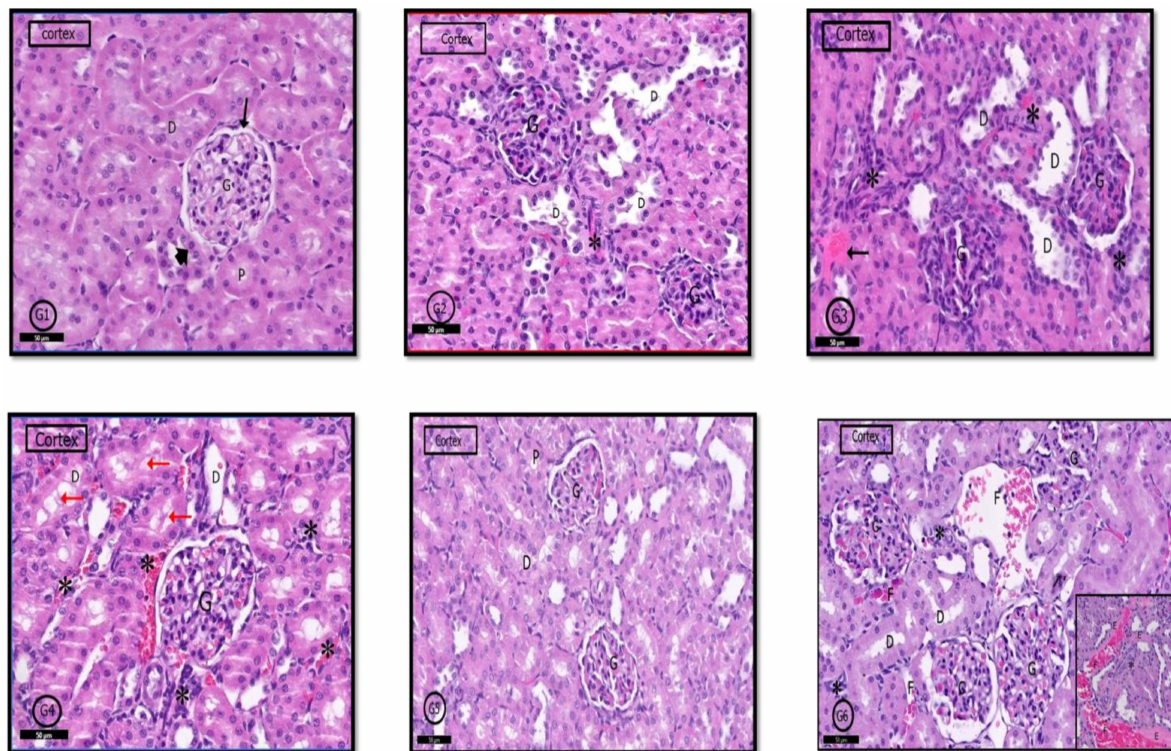
Figure 9. Photomicrographs of the rat renal cortex of different groups: In control rats ( G1 ), normal renal cortical parts like glomerulus (G) in Bowman’s capsule ( ↑ ). (PCT) proximal convoluted tubules (D,P) and (DCT) distal convoluted tubules (head arrow) were seen. ( G2 ) (PILO rats) showed localized areas of degeneration in the form of hypertrophied glomerular capillary loops (G) with dark nuclei. DCT had wide lumen (D); in addition to infiltrated inflammatory cells (*). In ( G3 ) (PILO+LPS rats) and ( G4 ) (PILO+LPS+VPA rats), signs of cortical degeneration were evident in the form of sclerotic glomeruli (G), wide DCT (D), infiltrated inflammatory cells with hemorrhage (*) and areas of exudate ( ↑ ). ( G5 ) (PILO+LPS+Celecoxib rats) showed nearly normal renal cortical architecture of renal corpuscle (G), PCTs (P), and DCTs (D). In general, ( G6 ) (PILO+LPS+VPA+Celecoxib rats) showed similar architecture as control rats but in localized areas (see also inset), collapsed glomeruli (C), interstitial infiltration (*) and focal interstitial widening with hemorrhage (F) and pink exudate (E) were seen. Stain: H&E. Bars: 50 µ m Inset ×